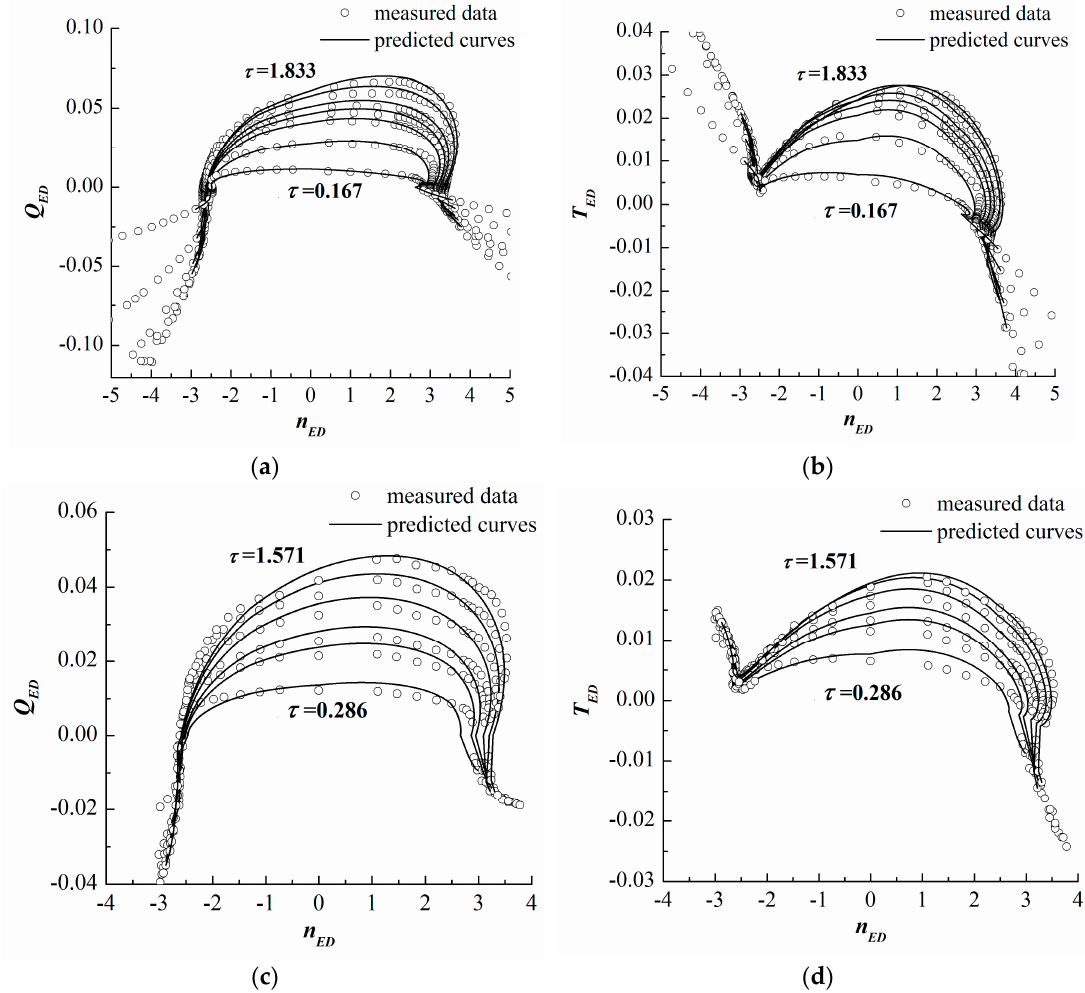
n Q − ED ED n Q − of the ED ED